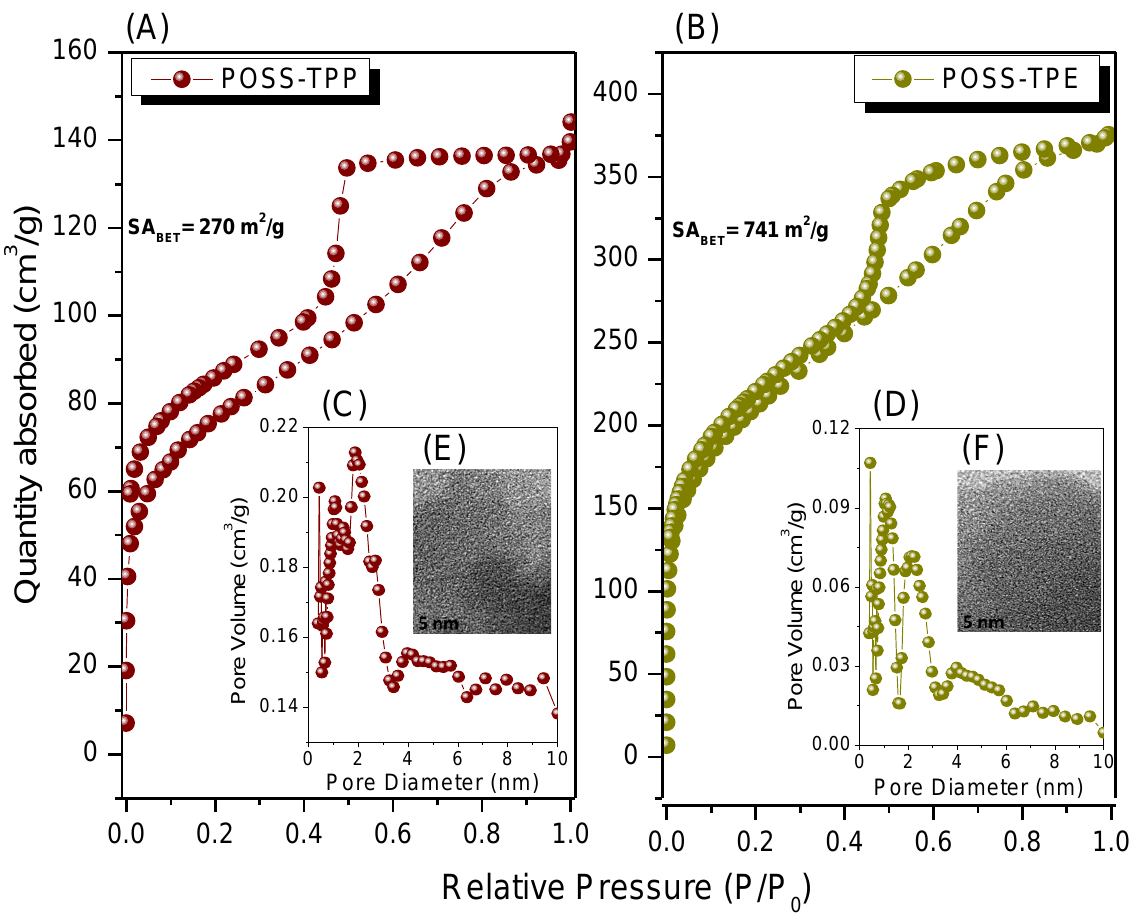
Figure 7. N 2 adsoprtion and desorption measurements of ( A ) POSS-TPP and ( B ) POSS-TPE; pore size distributions of ( C ) POSS-TPP and ( D ) POSS-TPE; and TEM images of ( E ) POSS-TPP and ( F ) POSS-TPE.